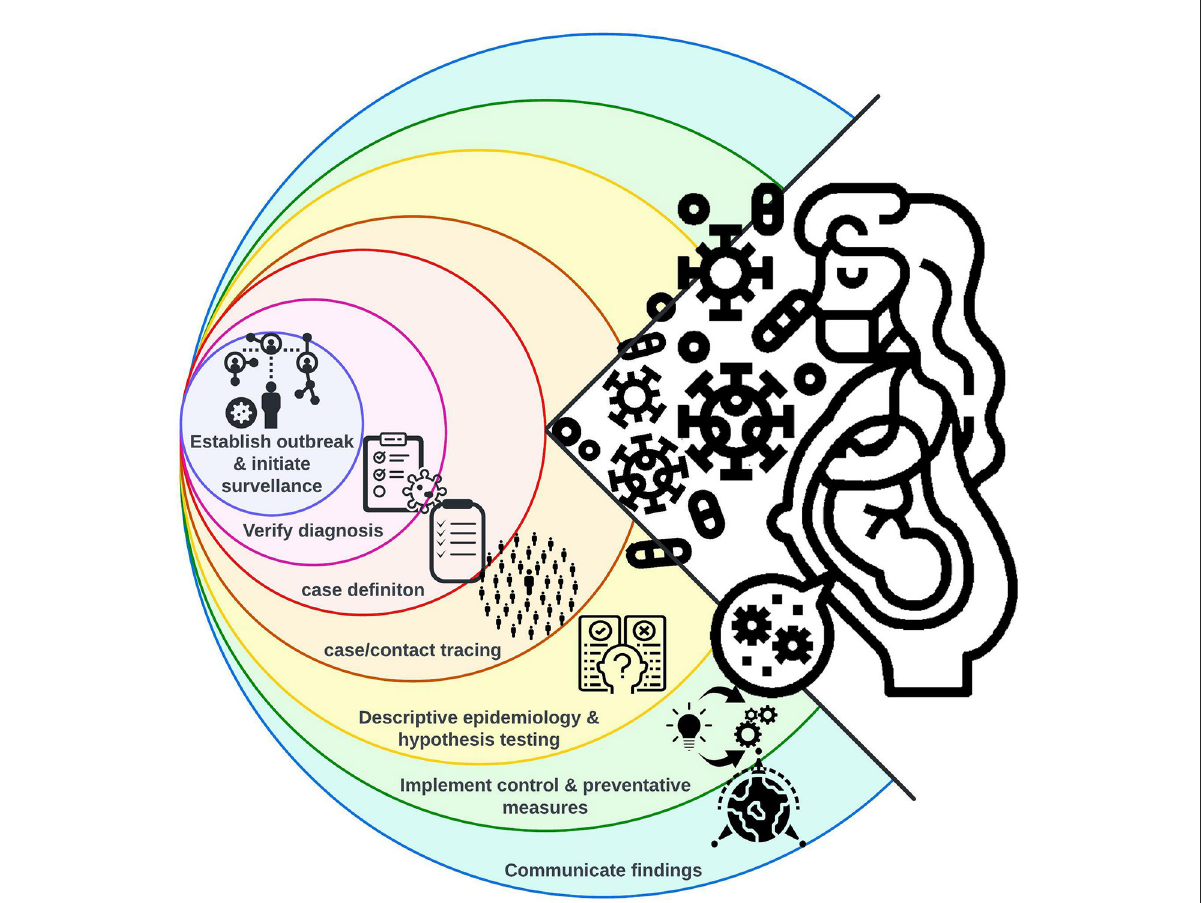
FIGURE1 The nine epidemiological principles (condensed into seven steps) employed in outbreak response [adapted from (2)]. Consideration of the at-risk pregnant population should be built into each step allowing for continuous monitoring of perinatal health outcomes and rapid provision of necessary pregnancy